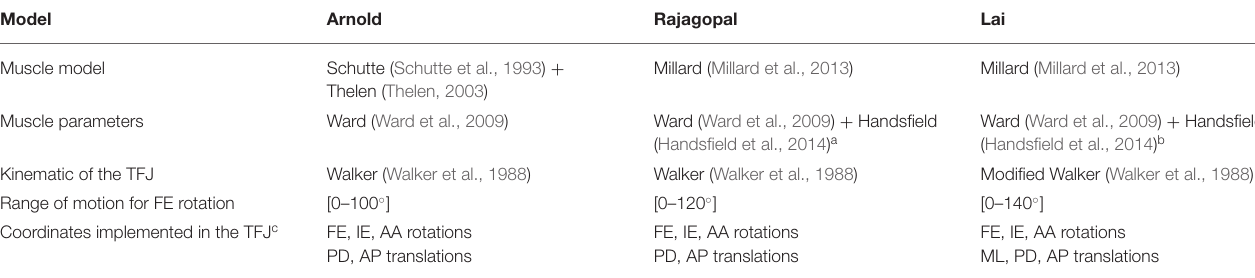
TABLE 1 | Main differences among the three models, i.e., Arnold, Rajagopal, and Lai. Model